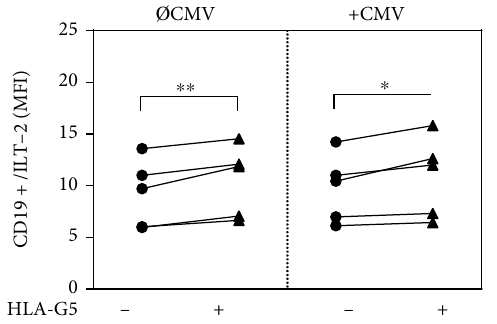
Figure 1: Incubation with Human leukocyte antigen G5 (HLA-G5) signi fi cantly increases the surface expression of ITIM-bearing Ig- like transcript (ILT-2) in CD19+ splenic cells. Di ff erences in ILT-2 expression on splenic CD19+ cells derived from cytomegalovirus (CMV)-seropositive individuals ( n = 5 ) after overnight cultivation in the presence or absence of HLA-G5 and CMV antigens. The expression of ILT-2 was analyzed by fl ow cytometry. The ILT-2 expression is given as the mean fl uorescence intensity index (MFI). Statistical signi fi cance ( P < 0 : 05 ) was determined by two-tailed paired t -test. ∗ P < 0 : 05 , ∗∗ P < 0 : 01